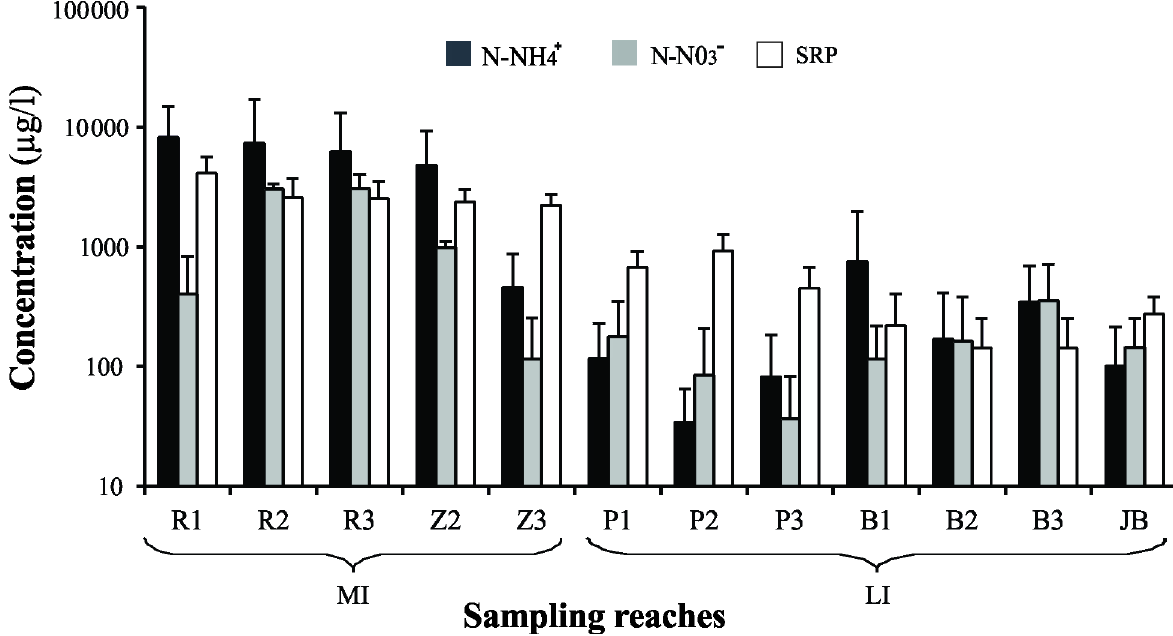
Figure 3. Mean concentration of nutrients in pampean streams sampled, Buenos Aires province, Argentina. MI: more impacted group; LI: less impacted group.